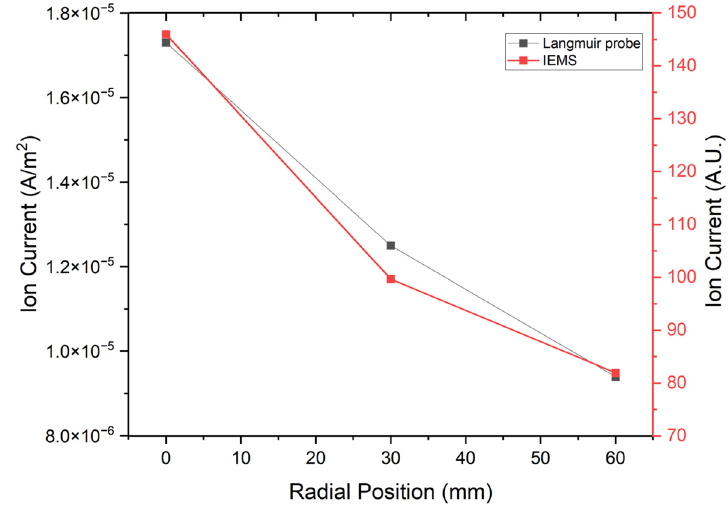
Figure 8. Comparison of the ion current using LP and IEMS. All data were acquired 30 s after plasma generation for stabilization.